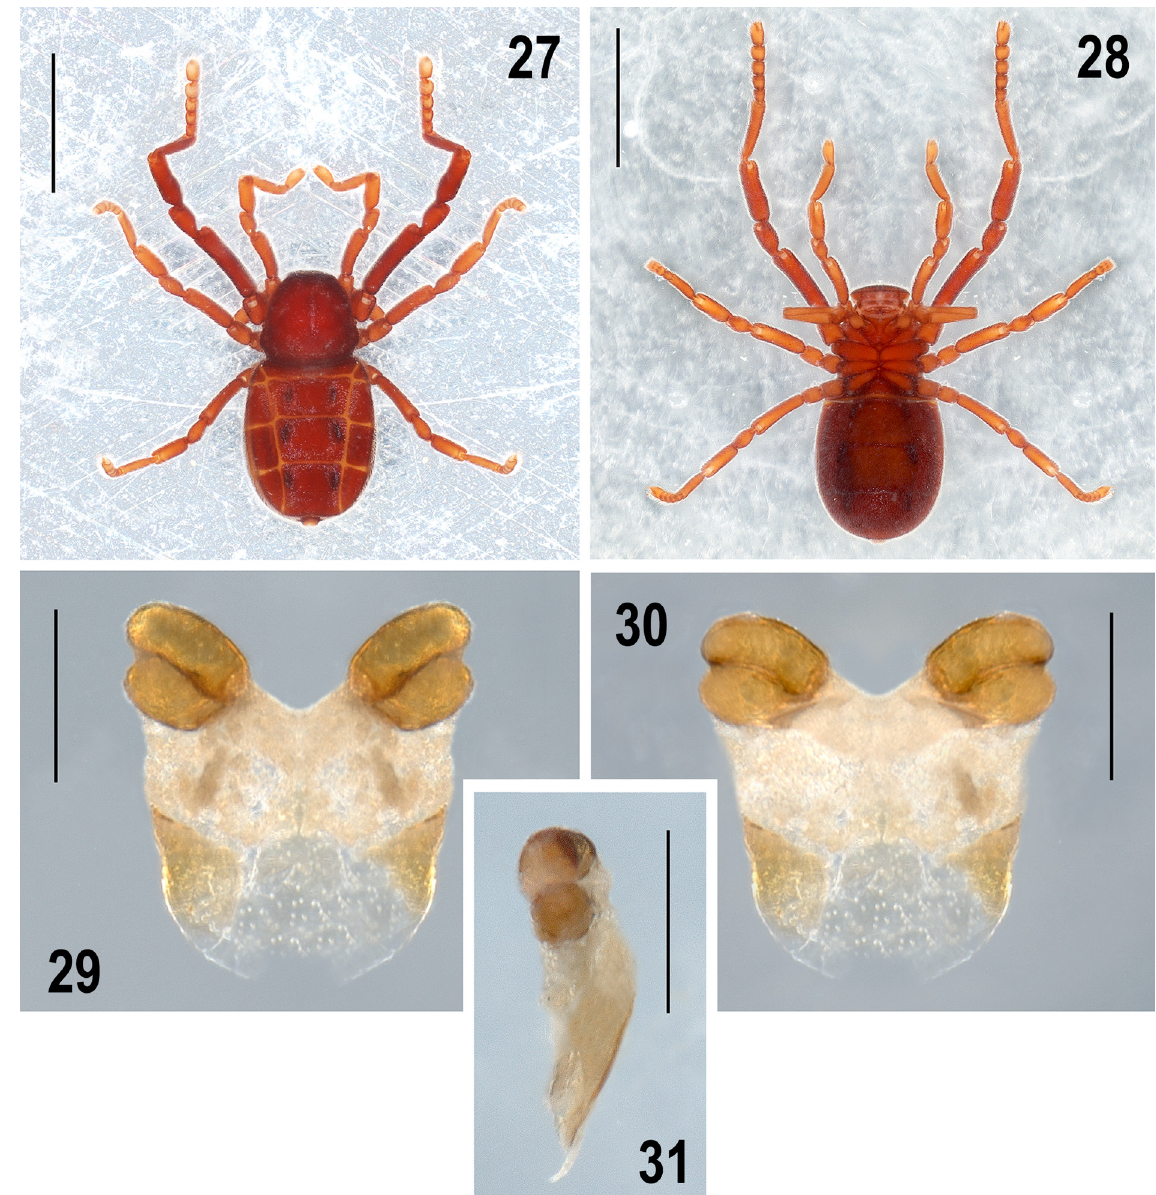
Figs 27–31. Pseudocellus giribeti sp. nov. Paratype, ♀ (MCZ 80010). 27–28 . Habitus, dorsal and ventral views. 29–31 . Spermathecae, anterior, posterior and lateral views, respectively. Scale bars: 27–28 = 2 mm; 29–31 = 0.2